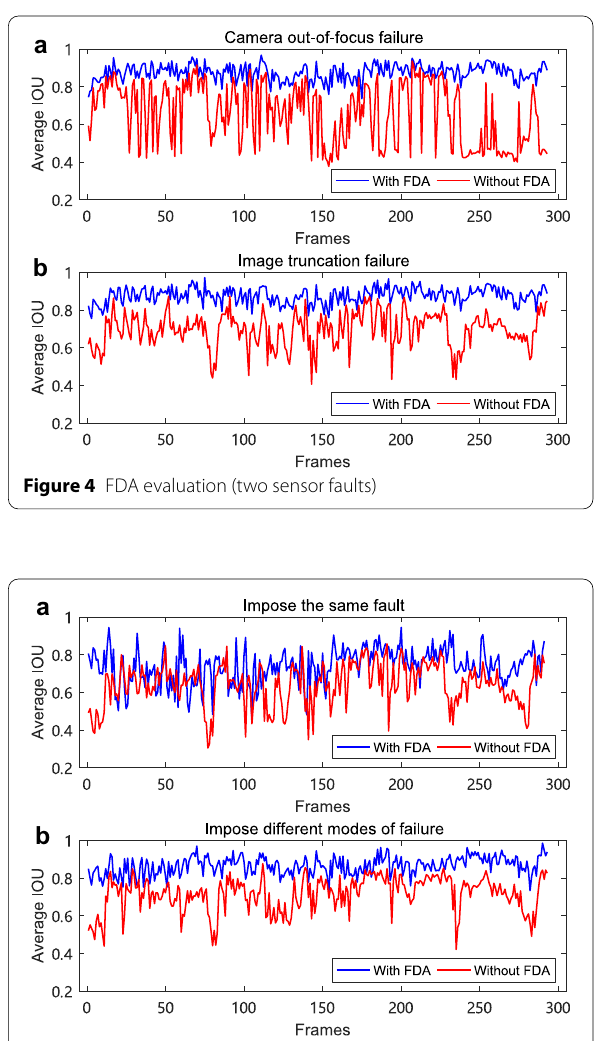
Figure 5 FDA evaluation (three sensor